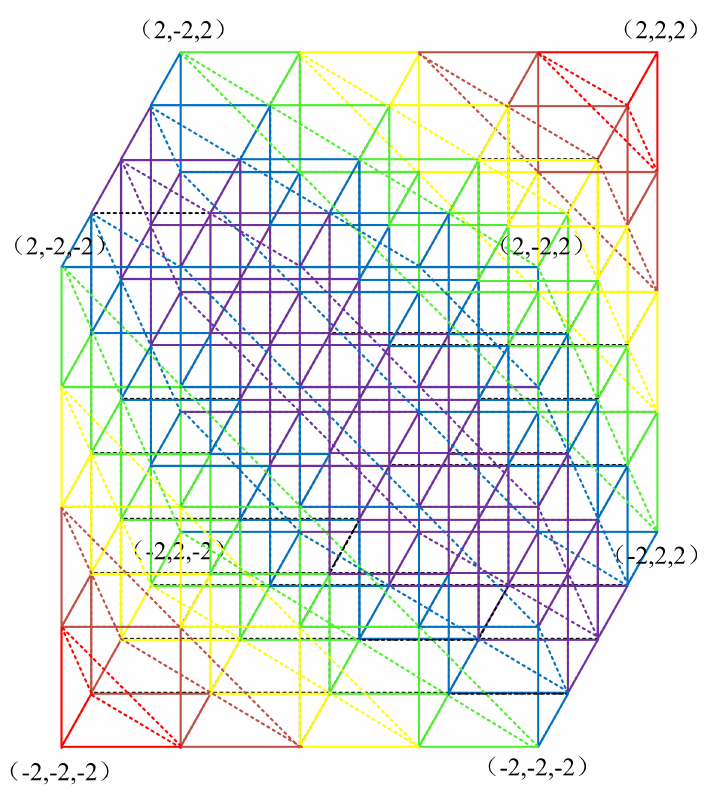
Figure 4. 3-D cube model voltage-balancing